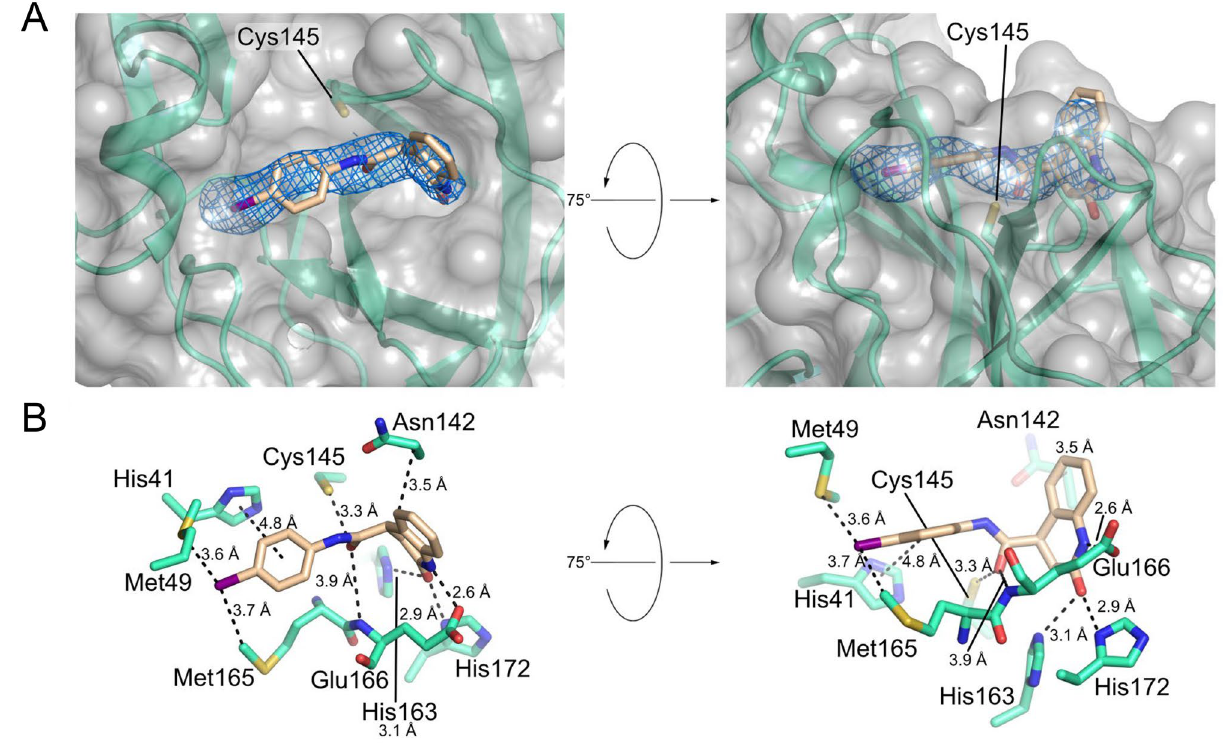
Figure 2. Crystal structure of M pro in complex with the dihydro-quinolinone compound Z222979552. ( A ) Surface representation of SARS-CoV-2 M pro with secondary structure elements colored green and compound Z222979552 shown as a stick model. The omit electron density map corresponding to the ligand compound is shown (σ = 1.0). ( B ) Stick model of compound Z222979552 and of select residues at the active site of M pro showing the key interactions between the protease and its